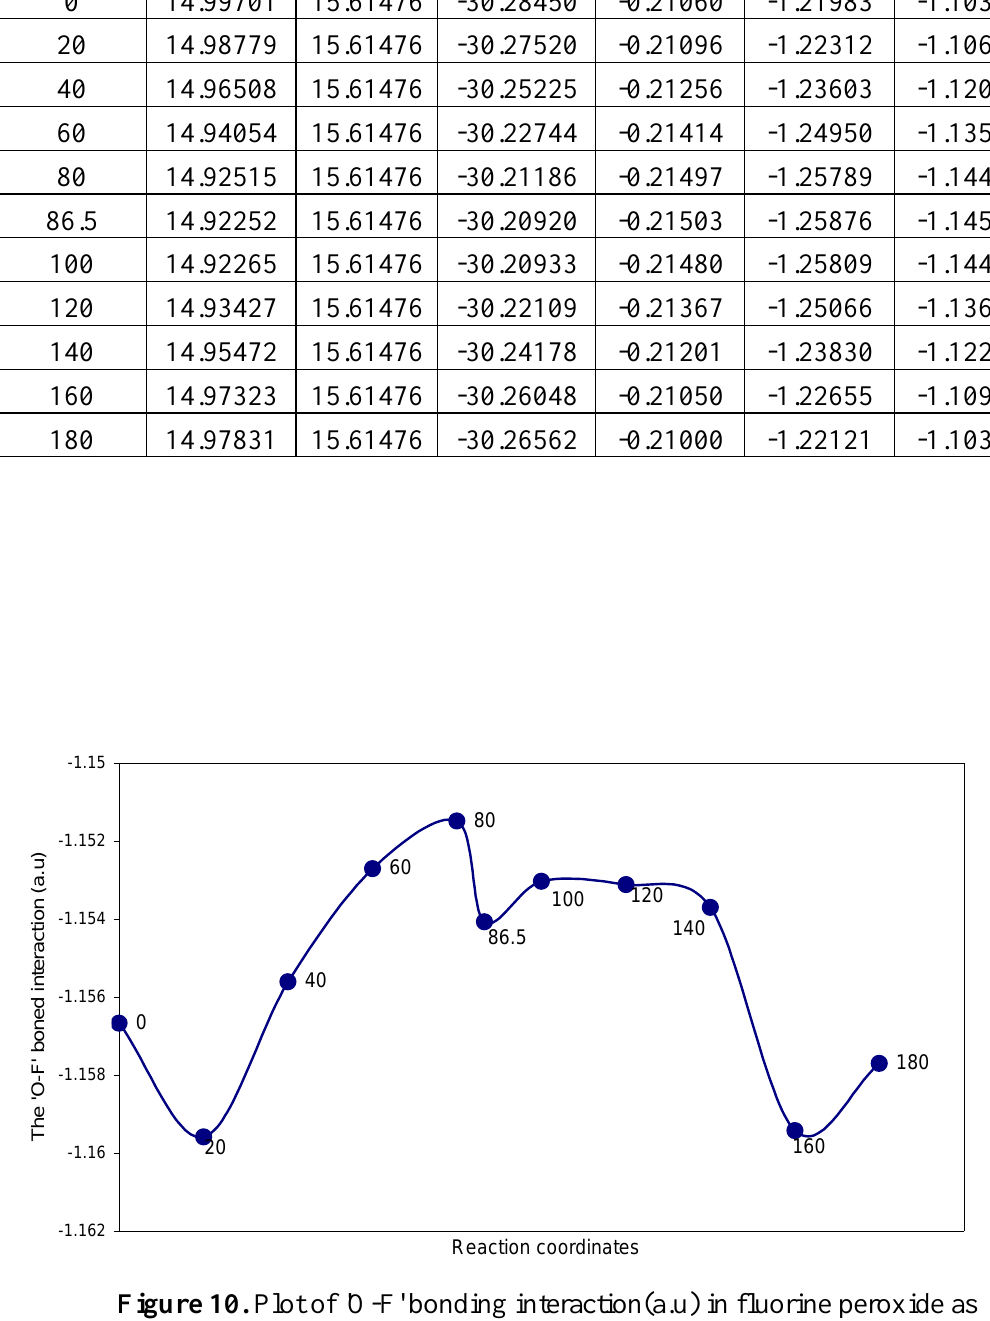
Table 9. The two-center ‘O–O’ bonding interaction and their physical components (a.u) in O